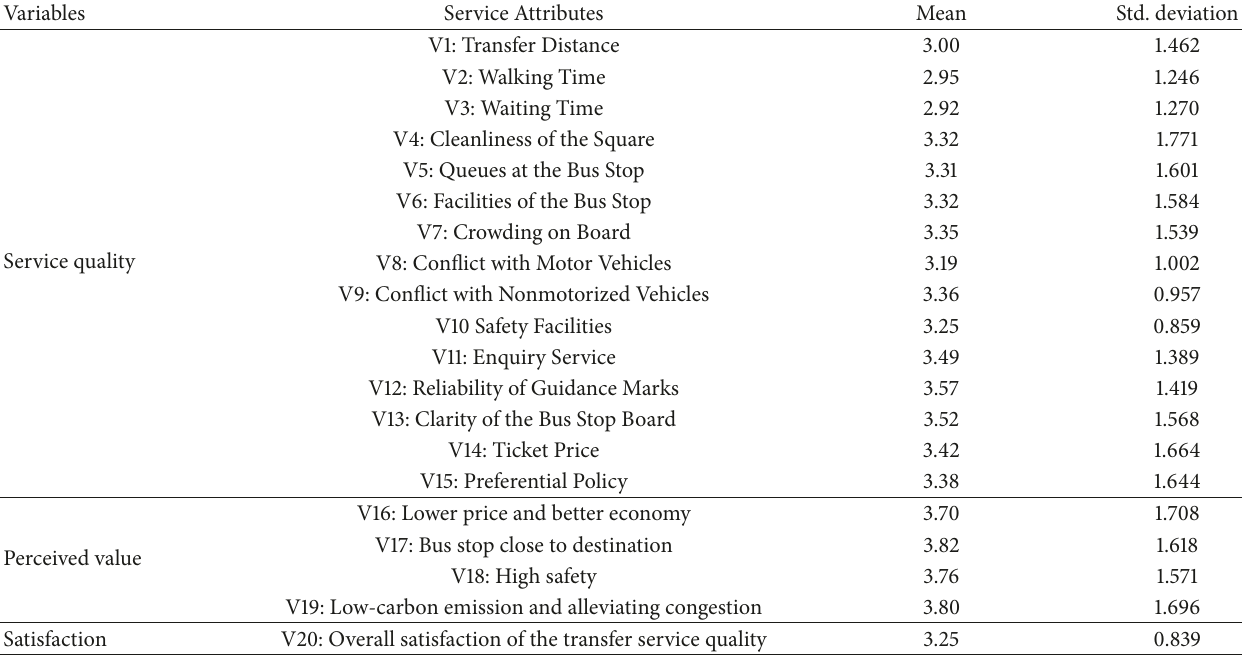
Table 3: The assessed attributes and the mean and standard deviation of the satisfaction rates.